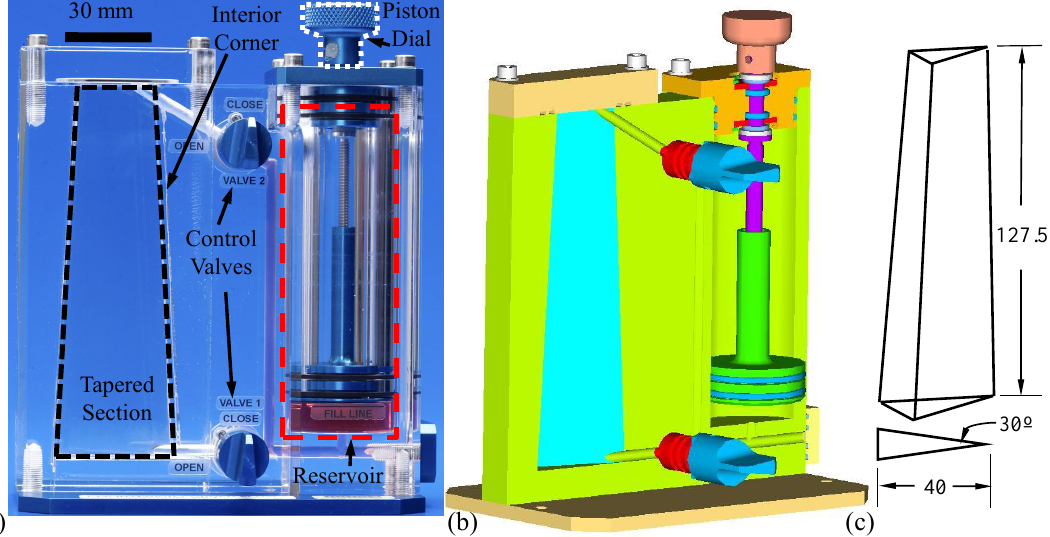
Figure 3. Annotated ICF-1 test Vessel: ( a ) apparatus, ( b ) solid model, and ( c ) wire model with dimensions in mm, where large ( bottom ) to small ( top ) cross-sectional isosceles triangles are congruent through a 20:13